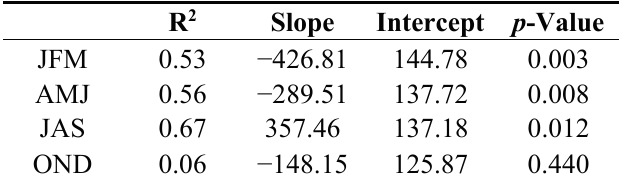
Table 5. Calibration coefficients for the algorithm for each period.